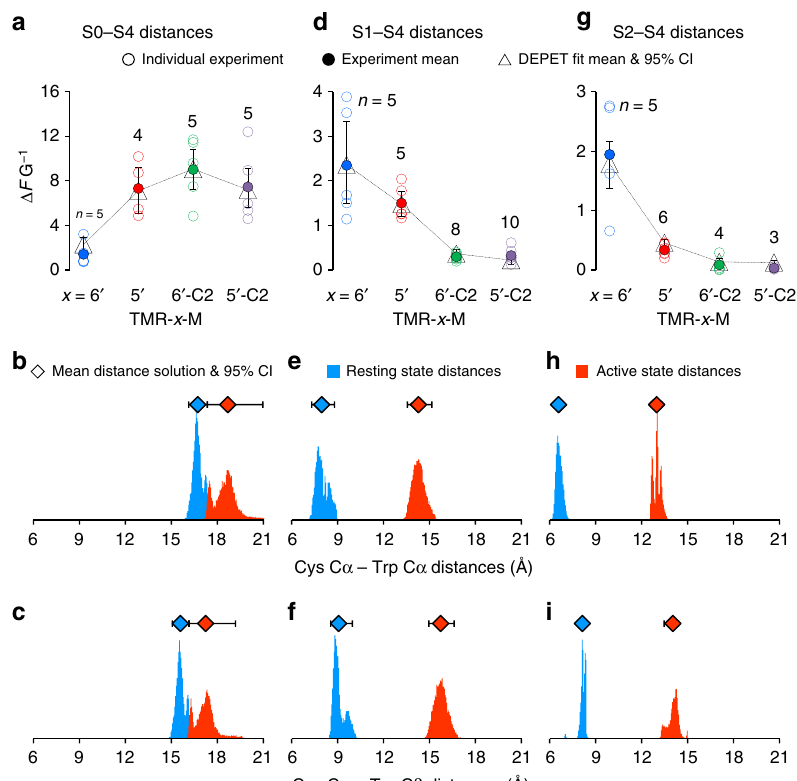
Fig. 4 Distances in the BK channel before and after membrane depolarization. a DEPET data (conductance-normalized, voltage-dependent fl uorescence change, Δ F / G ) from individual experiments (open circles) and mean ( fi lled circles) for TMRM fl uorophores of increasing length (left to right) conjugated to helix S0 (labeled Cys at position 19) and exhibiting state-dependent quenching by W203, at S4. Representative traces in Supplementary Figure 5. Open triangles represent mean DEPET fi ts; number of experimental replicates are shown next to the symbols. b Distributions for the DEPET solutions (10,000 boostrapped replicates) for the C19 (S0) and W203 (S4) C α atom distance ( d αα ) in the Resting (blue) and Active (red) conformation. The diamond symbols above the distributions represent their means. c The distance between the C19 C α and W203 C β atoms ( d αβ ), in the Resting (blue) and Active (red) conformation. c (the coef fi cient to convert quenching probability to Δ F G − 1 ) was 1.38 [0.53,6.70] ×10 6 . Note that d αα > d αβ , suggesting that W203 points towards helix S0 in both Active and Resting conformations of the BK voltage-sensing domain. d – f DEPET data and fi ts, from TMRM fl uorophores conjugated to position 136, extracellular to helix S1. Representative traces in Fig.2. c = 3.57 [2.34,5.00] × 10 5 . g – i DEPET data and fi ts, from TMRM fl uorophores conjugated to position 145, extracellular to helix S2. Representative traces in Supplementary Figure 6. c = 4.01 [2.31,5.53] × 10 5 . Note that d αα < d αβ , for both S1 and S2, indicating that the S4 Trp side-chain points away from these helices (See Fig. 5). These distances are also shown compared to distances from the cryo-EM BK channel structures in Supplementary Table 3. A determination of the W203 C α coordinates in the Active state of the BK channel VSD is shown in Supplementary Figure 10. All error bars are 95%